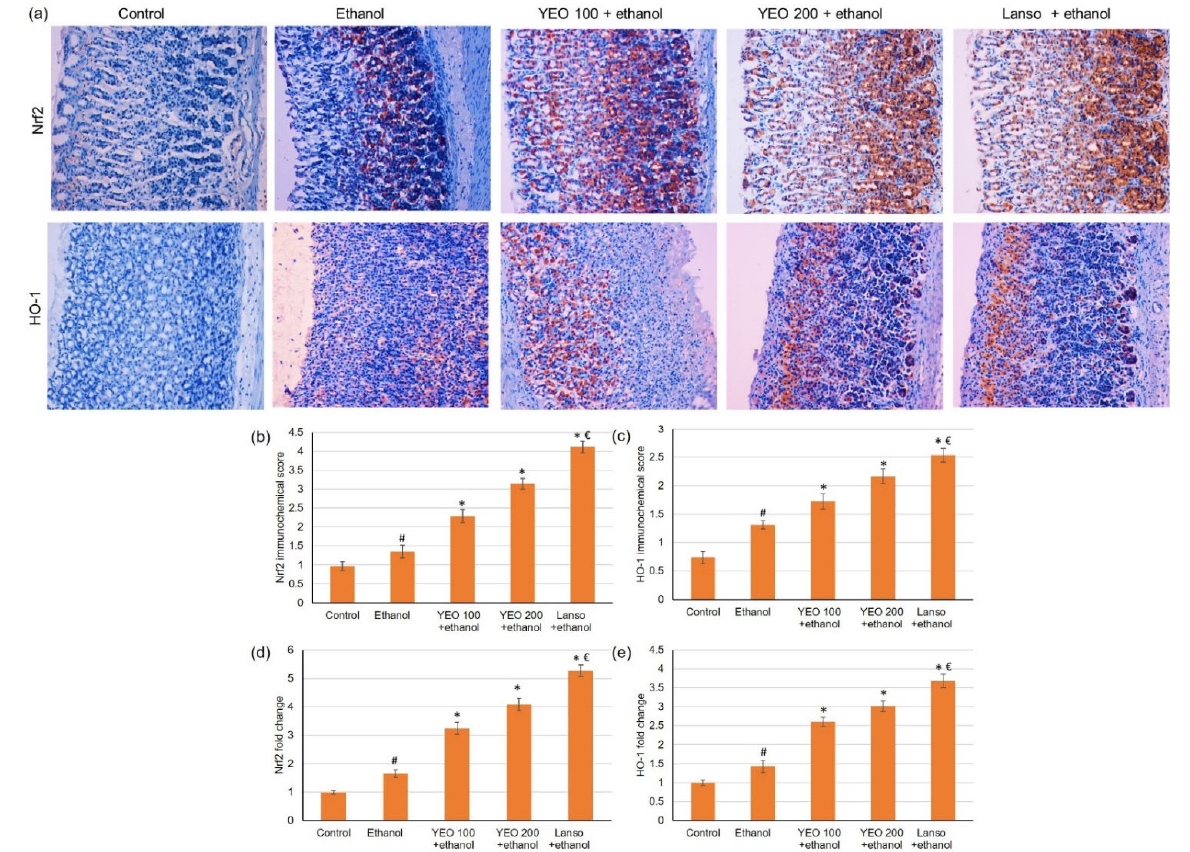
Figure 3. Effects of YEO (100 and 200 mg/kg) administration in acute gastric mucosal injuries induced by ethanol in rats on immunohistochemical analysis of ( a ) Nrf2 and HO-1 expressions, immunohistochemical scores for ( b ) Nrf2 and ( c ) HO1 and on the gene expression of ( d ) Nrf2 and ( e ) HO1. All data are quantified as mean ± SE, ( n = 6 ). (#) defines statistically significant related to the control, (*) signifies statistically significant related to the ethanol-induced gastric mucosal injuries, and ( € ) designates statistically significant related to YEO 200 + ethanol via one-way ANOVA after Tukey’s post hoc test ( p <